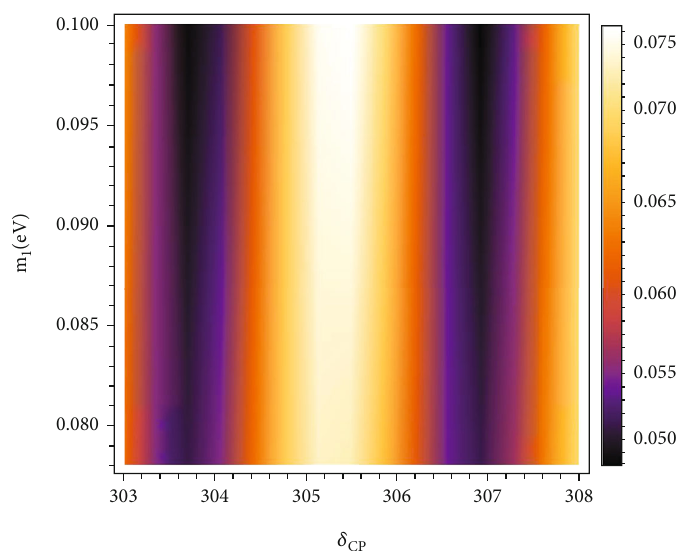
Figure 12: Predictions in the broken μ − τ symmetry model for normal ordering: depicts the density plot of ( m decay for favoured values of m 0 − 10 ).